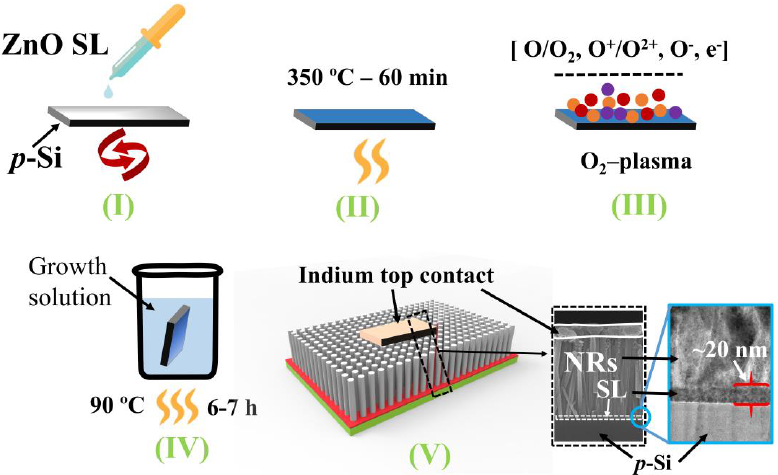
Figure 1. Process flow of the UV photodetector comprising the heterojunction structure of p-Si/n-ZnO NRs grown on SL post-treated by O 2 -plasma.